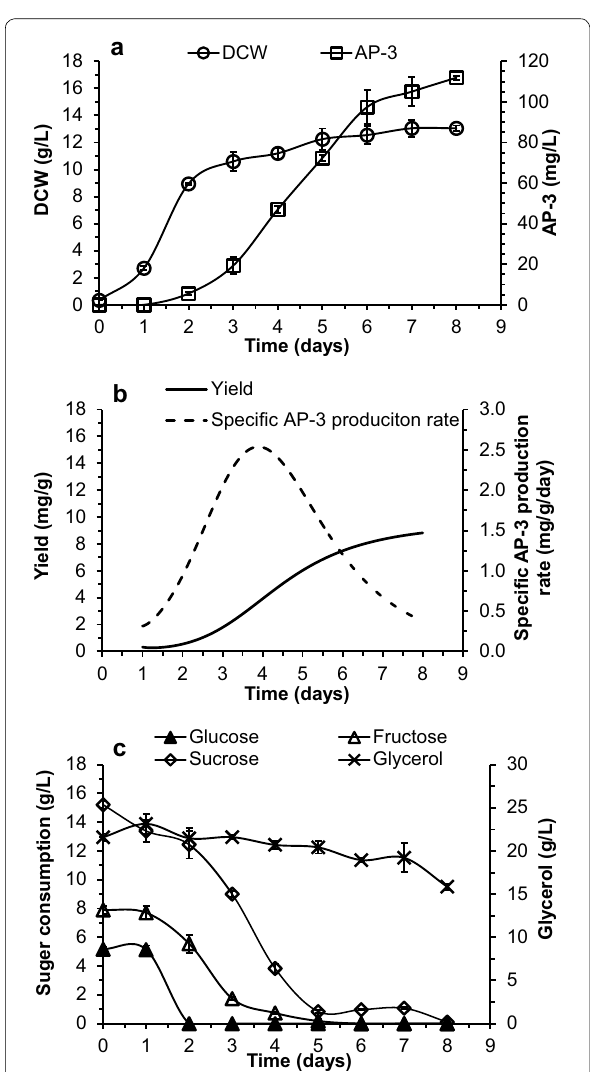
Fig. 3 Cell growth and AP‑3 fermentation of A. pretiosum in optimized medium. a Cell growth as determined by dry cell weight (circles) and AP‑3 production (squares); b AP‑3 yield (smooth curves) and specific AP‑3 production rate (dotted curves); c substrate consumption: glucose (black triangles), fructose (open triangles), sucrose (diamonds), and glycerol